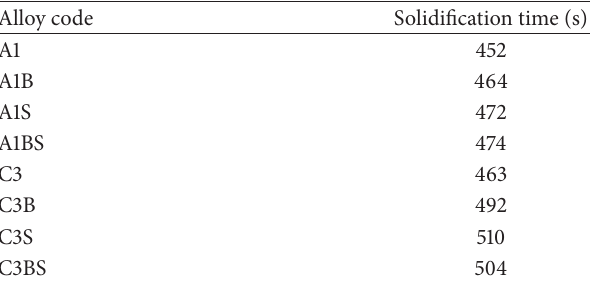
Table 4: Solidification times of the A and C3 series of alloys obtained from their cooling curves. Each value is an average of five consecutive